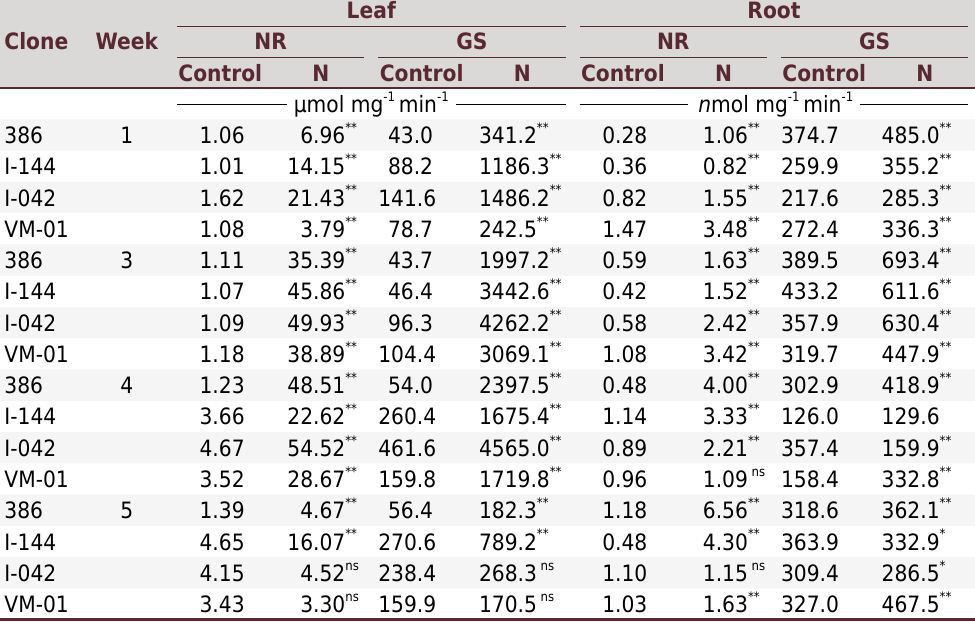
Table 6. Activity of the enzymes nitrate reductase (NR) and glutamine synthetase (GS) in diagnostic roots and leaves of Eucalyptus clones (386, I-144, I-042 and VM-01) subjected to nitrogen omission (weeks 1 and 3) and nitrogen resupply (weeks 4 and 5) and control treatments